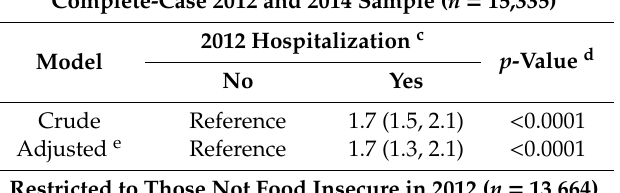
Table 4. Odds ratios and 95% confidence intervals for the influence of hospitalization on food insecurity a,b . Complete-Case 2012 and 2014 Sample ( n = 15,335)